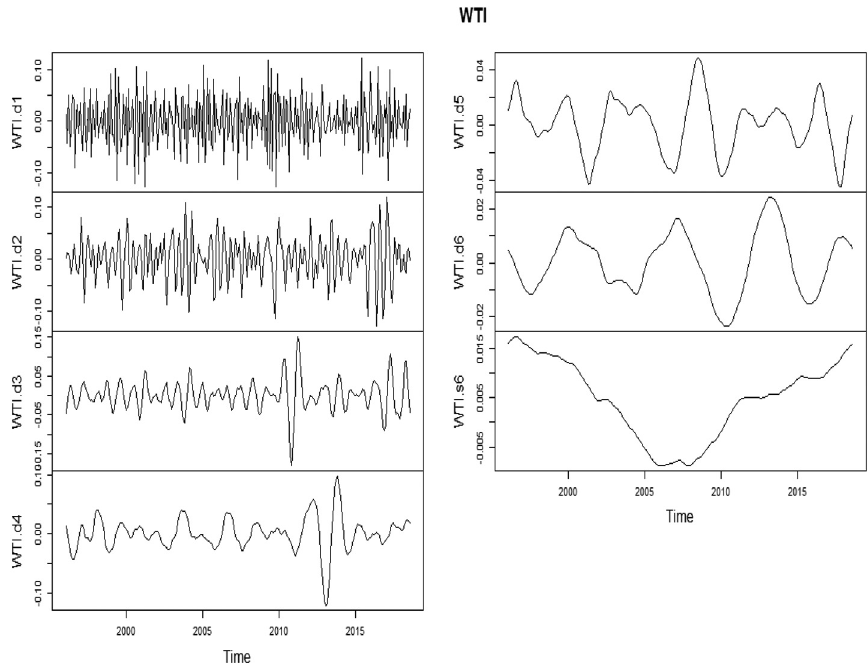
Figure 1. MODWT plot of decomposed series